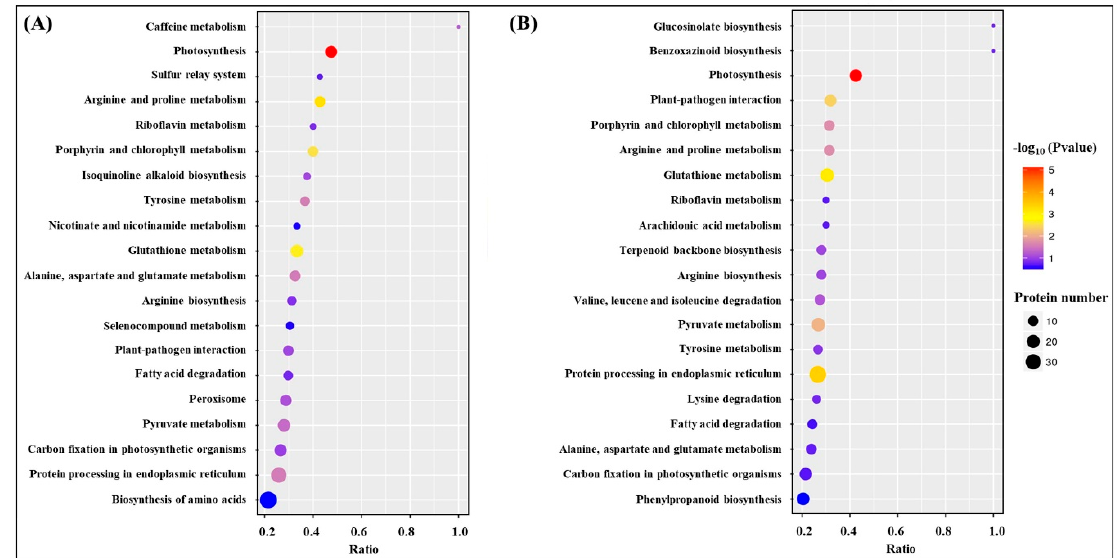
Figure 8. The effect of heat stress without (HS vs. C) and with (HSG vs. C) exogenous γ -aminobutyric acid (GABA) application on differentially expressed proteins (DEPs) within each functional category based on the clusters of orthologous groups (COGs) in leaf of creeping bentgrass. ( A ) HS vs. C and ( B ) HSG vs. C. C, control (normal condition); HS, heat stress; HSG, heat-stressed plants pretreated with GABA.